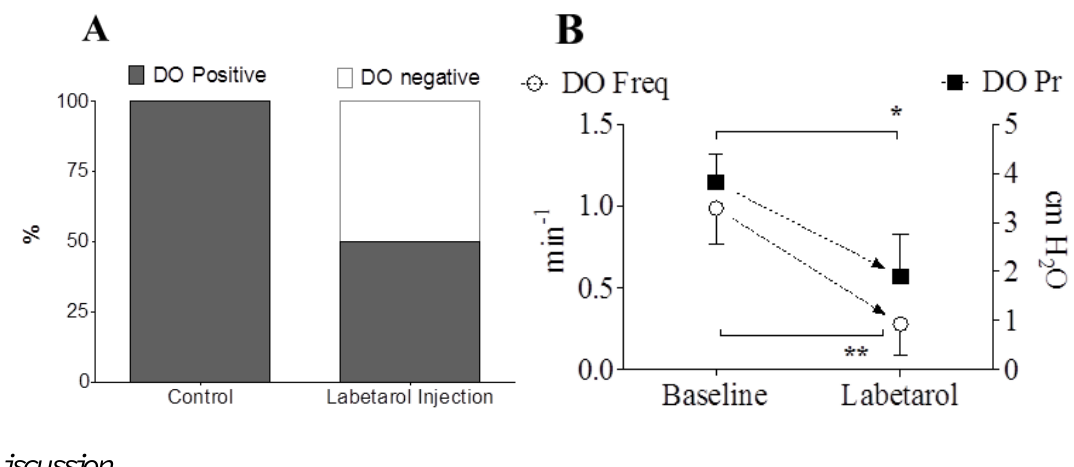
Figure 6. The effects of intraarterial 5 mg·kg −1 labetalol on the cystometric detrusor overactivity (DO)-related parameters during the filling phase in SHRs and Wistar rats. ( A ) DO occurrence rate; ( B ) DO frequency and pressure. Before the injection of labetalol, DO proved by IAP was shown in all SHRs. After the injection of labetalol, DO disappeared in 3 of 6 SHRs. Also, DO frequency and pressure decreased significantly. Results are expressed as mean ± standard error of the mean. * p < 0.05, ** p < 0.01 (unpaired Student’s t